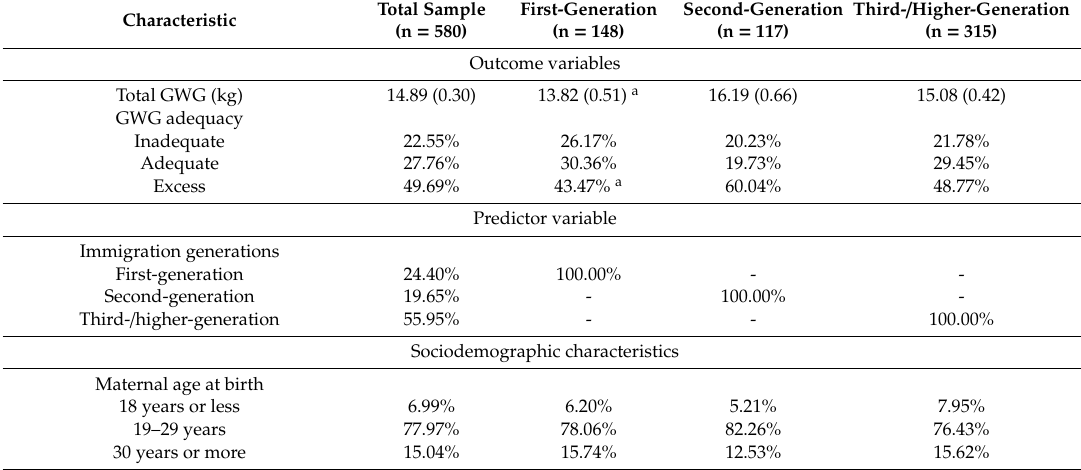
Table 1. Sociodemographic characteristics and pregnancy characteristics by immigration generation given as weighted percentage or mean